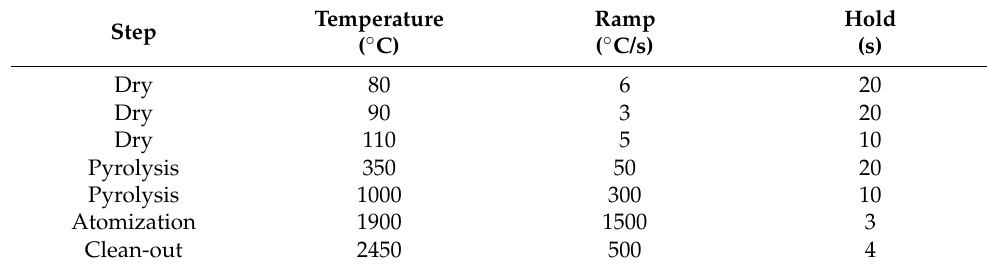
Table 1. Temperature program for the analyses of Ag + in the acceptor solution by graphite furnace atomic absorption spectroscopy.